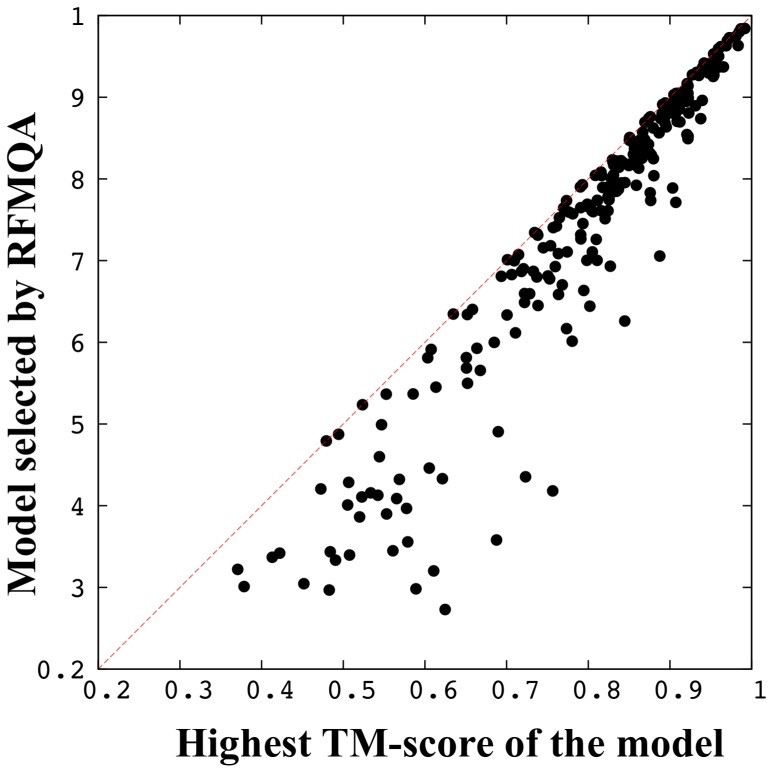
Five-fold cross-validation on CASP8 and CASP9 targets.TM-score of the best server model (TMbest) versus TM-score of the model selected by RFMQA (TMRF) for five-fold validation is shown. Pearson's correlation coefficient and the average TMloss between TMbest and TMRF are 0.945 and 0.055, respectively.